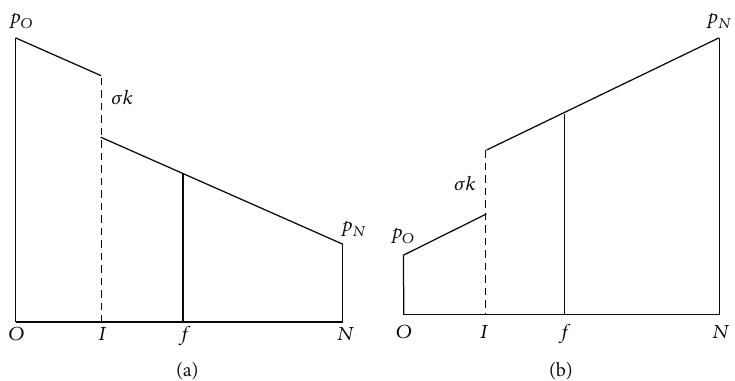
Figure 2: Pressure distribution along ON in di ff erent situations: (a) O is in the primary phase. (b) N is in the primary phase.